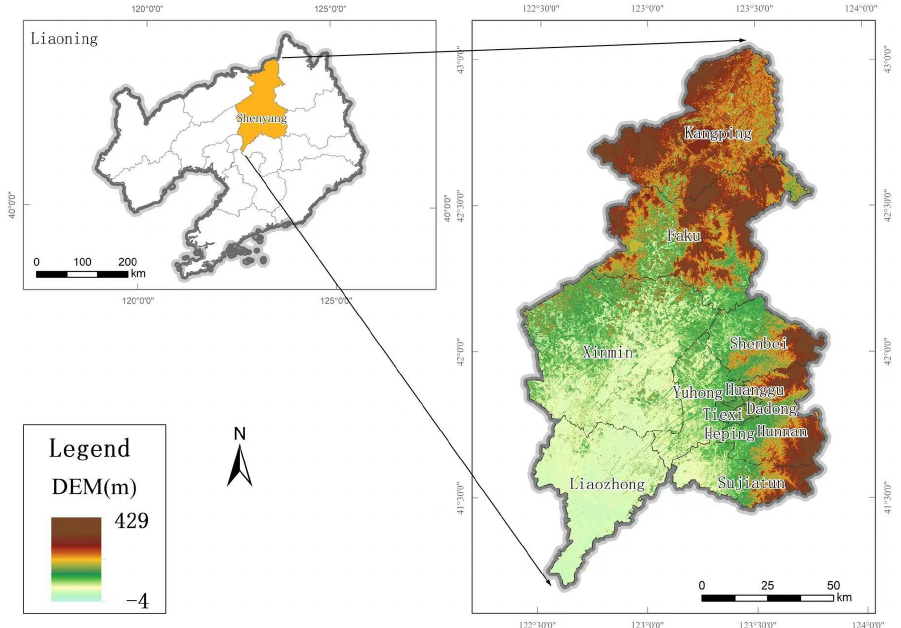
Figure 1. Schematic diagram of Shenyang’s location in Liaoning Province.